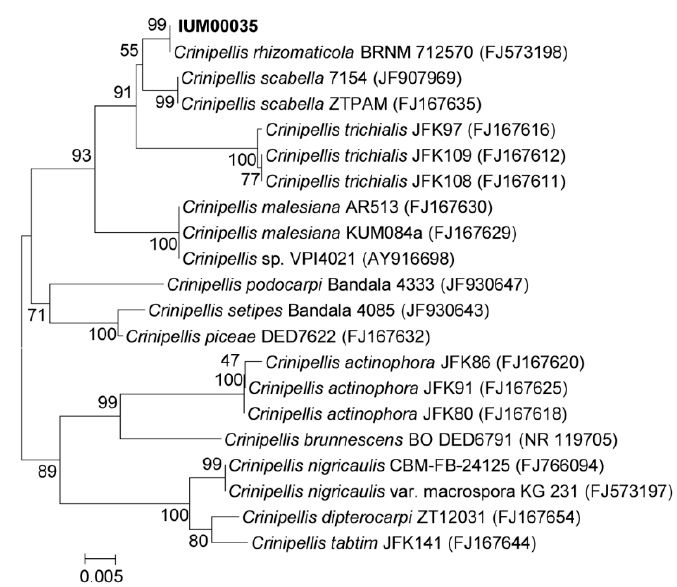
Figure 3. Phylogenetic analysis of the IUM00035 isolate. Phylogenetic analysis was performed based on the ITS region of IUM00035 and the other 20 Crinipellis species. The neighbor-joining method was used for this analysis, and numbers at the nodes indicate the levels of bootstrap support (%) by 1000 resampled datasets. NCBI accession numbers of each sequence are in parentheses. Bar, 5 substitution per 1000 nt.